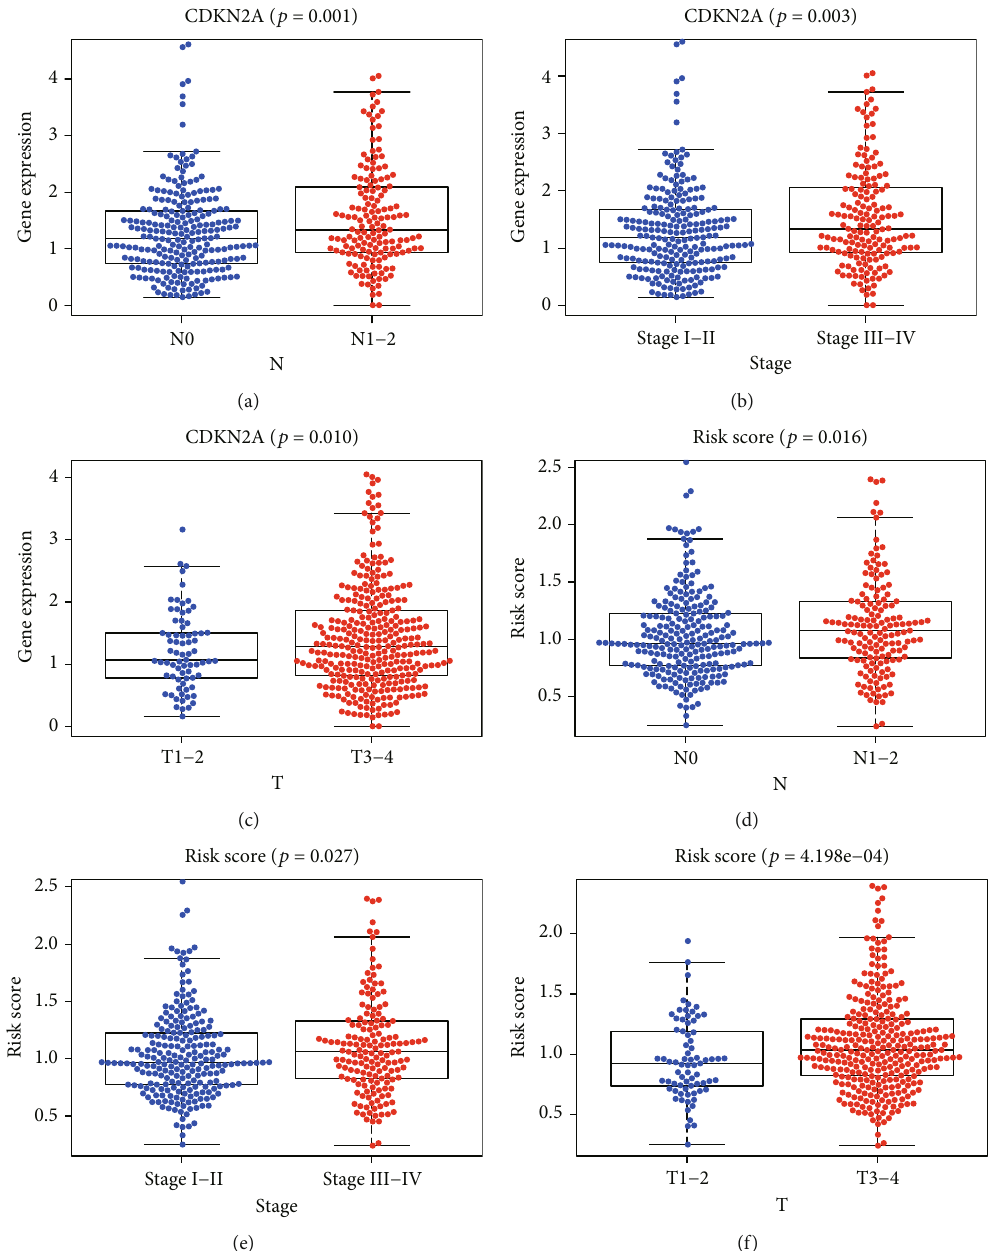
Figure 4: The close correlation between the ARP hub signatures and CRC clinical pathological factors ( p Filter = 0 : 05